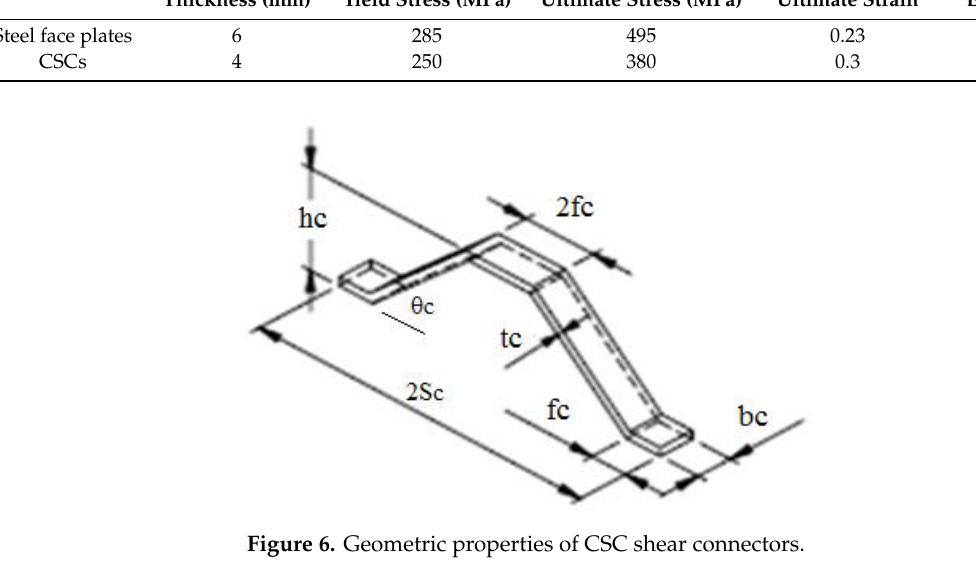
Figure 5. CSC shear connectors.